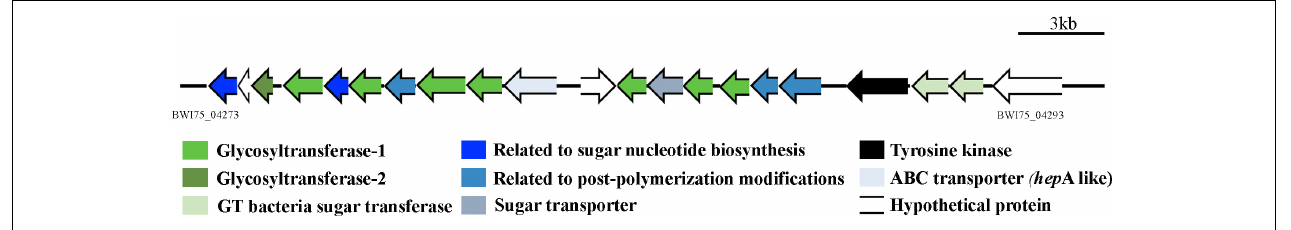
FIGURE 4 | Gene cluster likely associated to desiccation tolerance mechanisms. This gene cluster contains 10 genes encoding for glycosyltransferases whose orthologs in Anabaena demonstrated to be overexpressed under desiccation conditions (Yoshimura et al., 2007). Gene locus: PWI75_04273 to PWI75_04293. TABLE 2 | Genes associated to EPS export pathways in Gloeocapsopsis sp. UTEX B3054. Protein Synechocystis sp. Gloeocapsopsis sp.